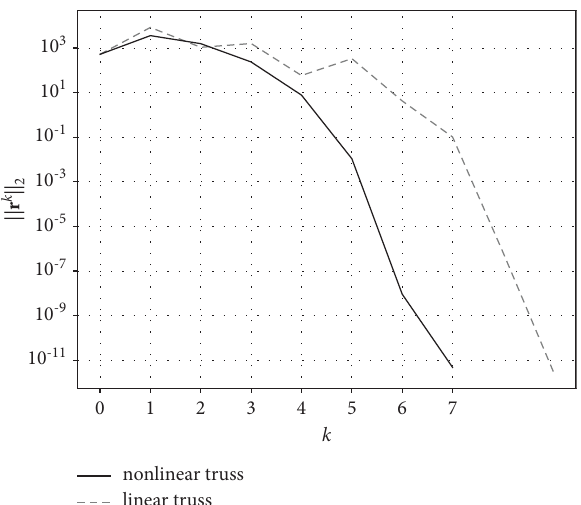
Figure 12: Convergence of the 3D frame system.